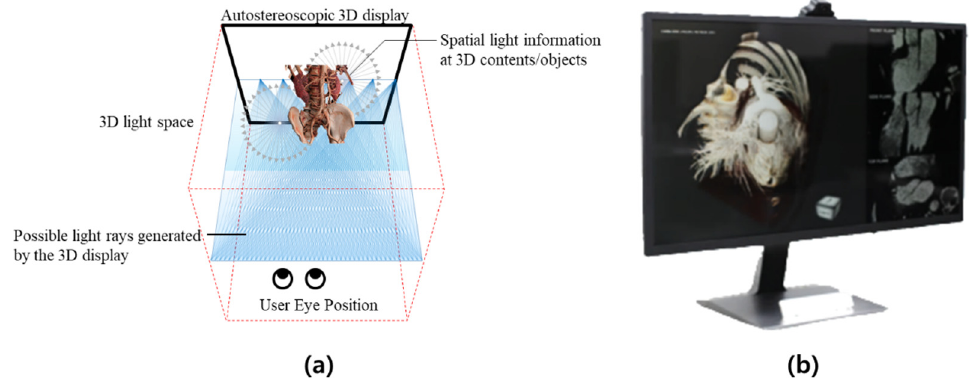
Figure 1. ( a ) Eye tracking-based light-field 3D display concept, showing the generation and modeling of directional light rays. ( b ) 3D display prototype for medical applications: 3D cardiac CT navigator.